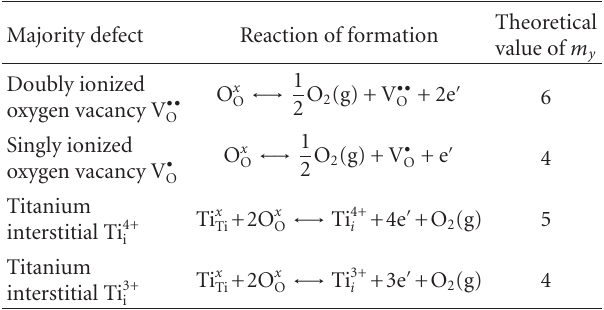
Table 1: Theoretical analysis of point defects formation in TiO 2 − y